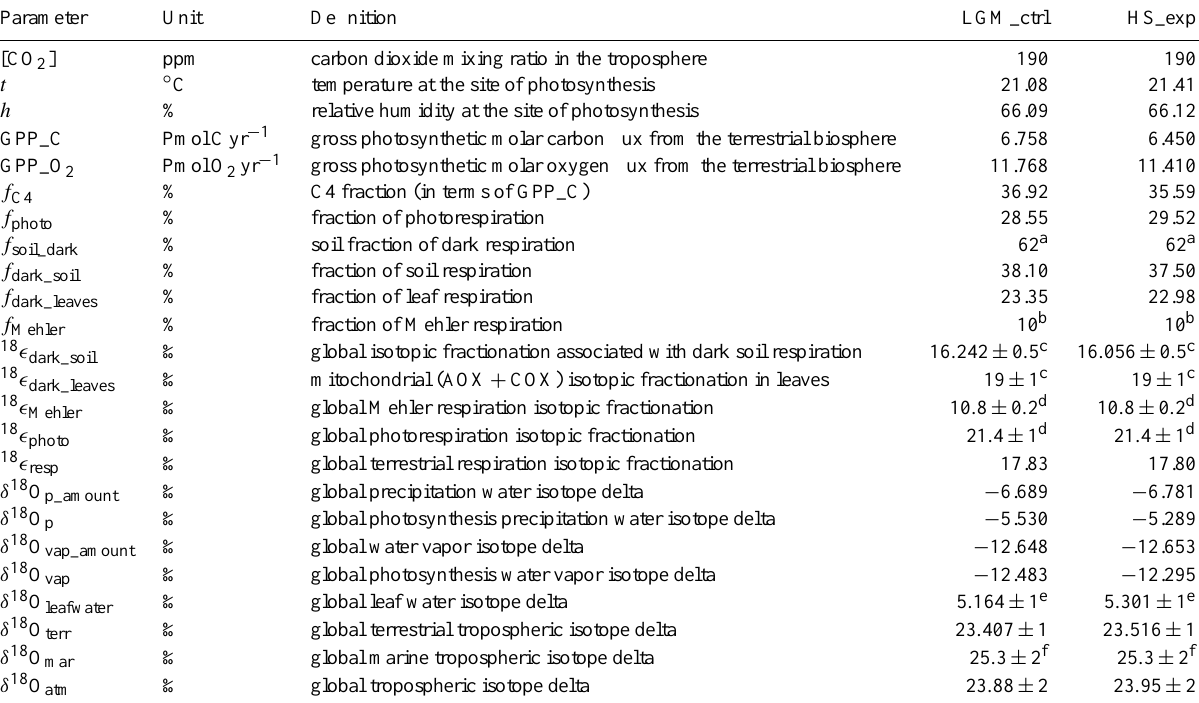
Table 2. Parameters involved in the calculation of δ 18 O atm . Uncertainties are given for most of the parameters except for those derived from the ORCHIDEE model.